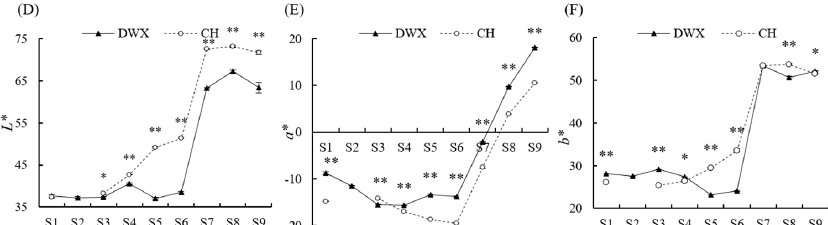
Figure 2. Fruit phenotype ( A ), weight ( B ), shape index ( C ), and color changes ( D – F ) during fruit development and ripening of Dawuxing and Chunhua loquats. The x axis in ( A ) presents days after full bloom (DAFB) and the longitudinal section of fruits corresponding to each DAFB are shown in ( A ). The x axes in ( B – F ) represent different developmental stages of loquat fruits. The asterisks in the line charts indicate significant differences (*: p ≤ 0.05; **: p ≤ 0.01).